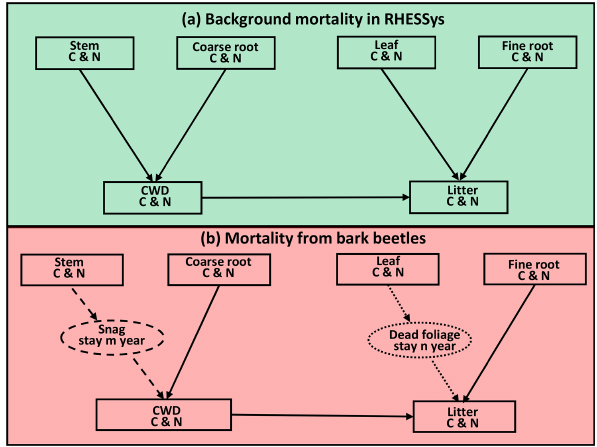
Figure 4. Conceptual framework of the beetle effects model. (a) Normal background mortality routine in RHESSys before the beetle outbreak. (b) Mortality from bark beetles. We added a snag (standing dead tree) and a dead foliage (needles still on dead tree) pool, as shown in the dashed and dotted circle, respectively. After a beetle outbreak, carbon (C) and nitrogen (N) move from the stem to the snag pool (dashed arrow). After staying in the snag pool for m years, C and N move on to the coarse wood debris pool (CWD) with an exponential decay rate to represent the snag fall (dashed arrow). There is a similar process for leaf C and N, which move from leaf to dead foliage to litter pool (dotted arrow). Furthermore, C and N in the CWD and fine root pools move to the litter pool immediately after the outbreak. Figure modified from Edburg et al.